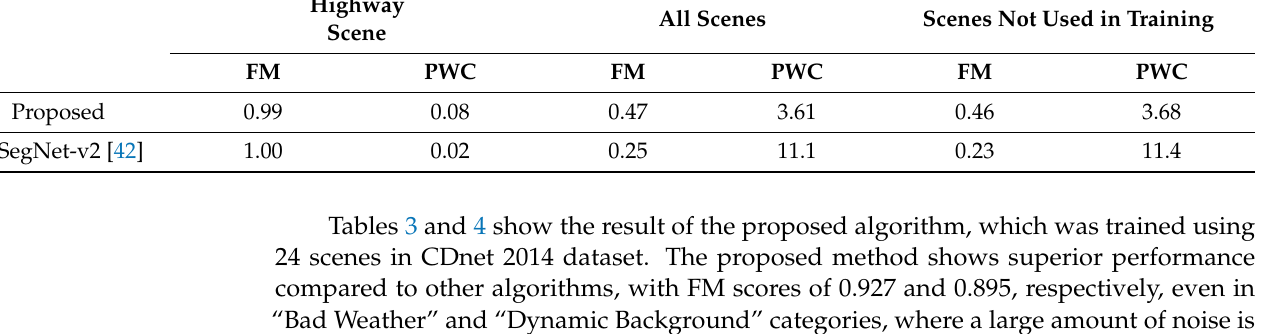
Table 3. Results of proposed method which is trained using 24 scenes in CDnet 2014 dataset.